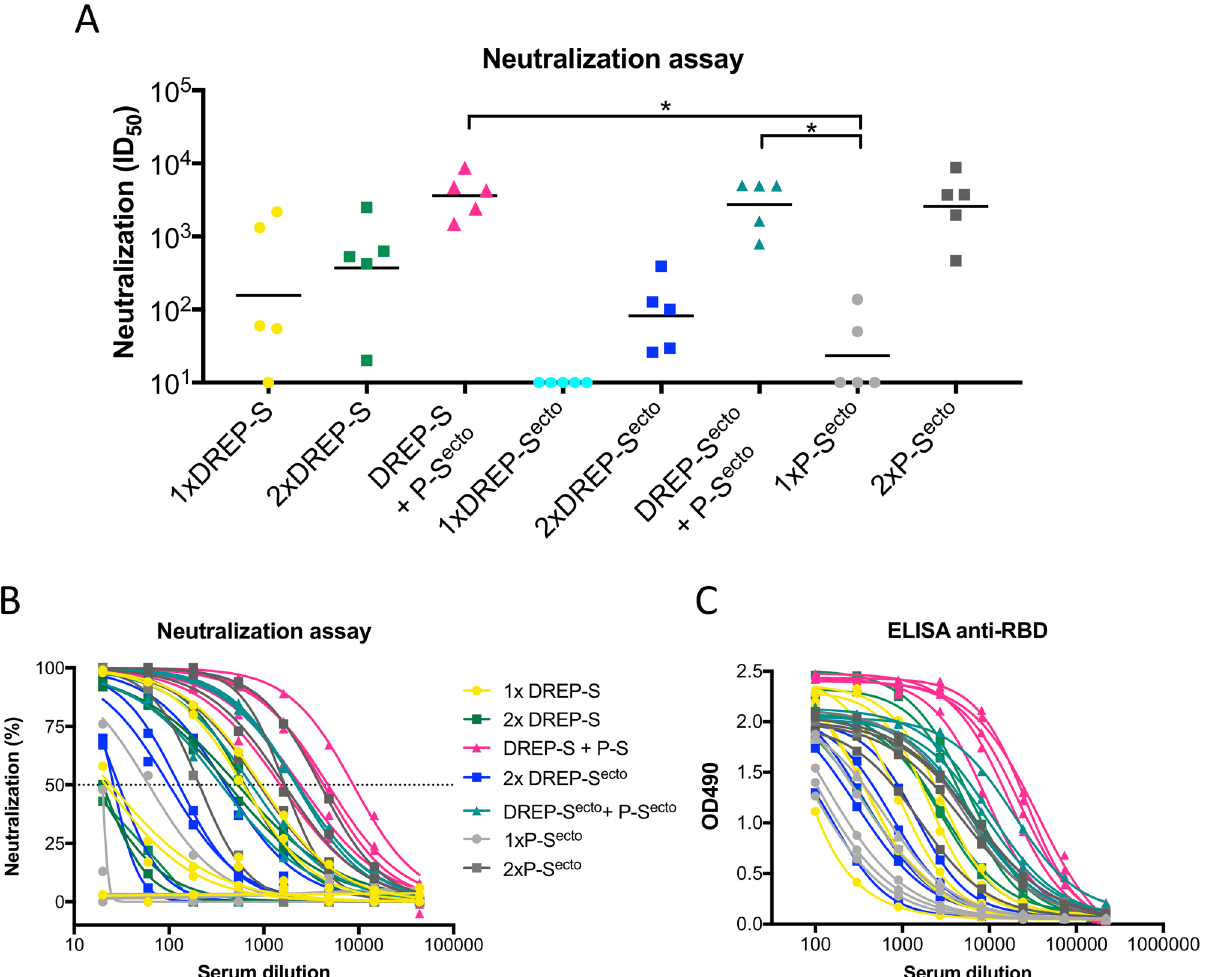
Figure 4. Antibody quantification and neutralization of the vaccinated mice. ( A ) Mice were immunized with 10 μg of candidate vaccines as indicated on the graph and serial dilutions of serum from vaccinated mice were assessed for neutralization of SARS-CoV-2 pseudotyped lentiviruses harboring a luciferase reporter gene. The ID 50 titers were calculated as the reciprocal dilution where infection (RLU) was reduced by 50% relative to infection in the absence of serum. The geometric mean ID 50 for each group is displayed. ( B ) Neutralization curves depicting percent neutralization against serum dilution. ( C ) Curves depicting OD490 readouts in anti-RBD ELISA assay detecting IgG binding antibodies in the serum of immunized mice. Across all groups, RBD-specific IgG titers correlated strongly with pseudovirus neutralization. Statistical analysis was performed comparing all groups except 1xDREP-S ecto using Kruskal Wallis test followed by Dunn’s test for multiple comparisons, * p <